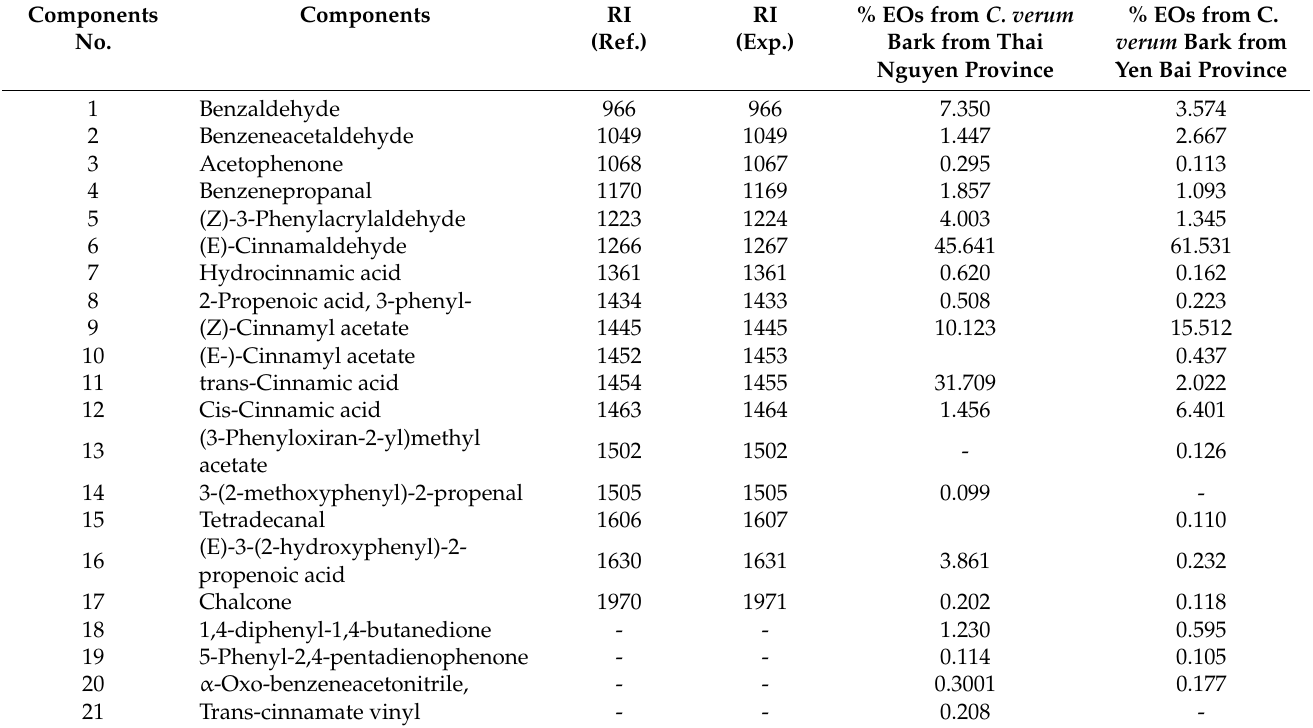
Table 3. Chemical components of C. verum bark EOs from different cultivation locations.